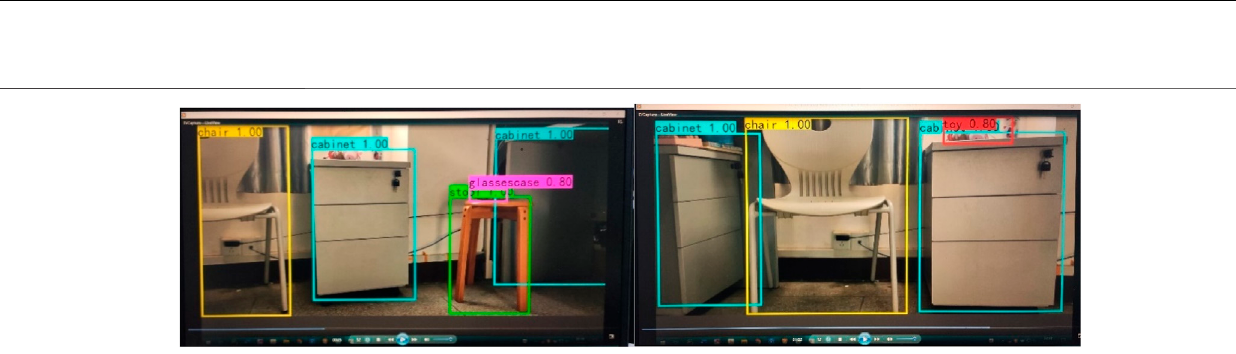
Frontiers in Bioengineering and Biotechnology |